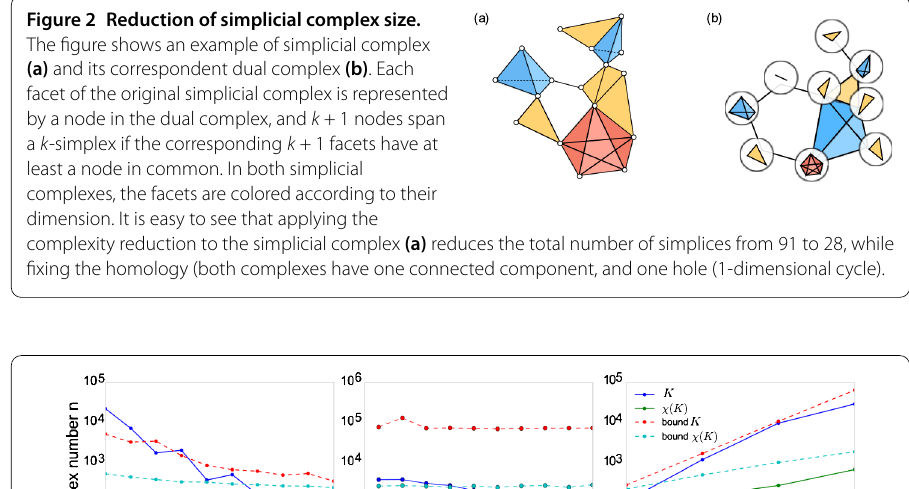
Figure 3 Performance of reduction of simplicial complex size. The panels show the total simplex number (solid lines) and the upper bound (dashed lines) for simplicial complexes built with facet size sequence sampled from the exponential (left), Zipf distribution (middle) and Poisson (right). On the x -axis we plot (from left to right) the power law exponent γ , the average value λ and the exponent ν . It is easy to see that in all cases and for a range of parameters there is a large reduction in simplex number going from K to χ ( K ). Moreover, the bounds on n ( K ) and n ( χ ( K )), although not tight, reflects closely that between n ( K ) and n ( χ ( K )) and can therefore be used as a good proxy to decide whether applying the simplicial reduction χ is appropriate or